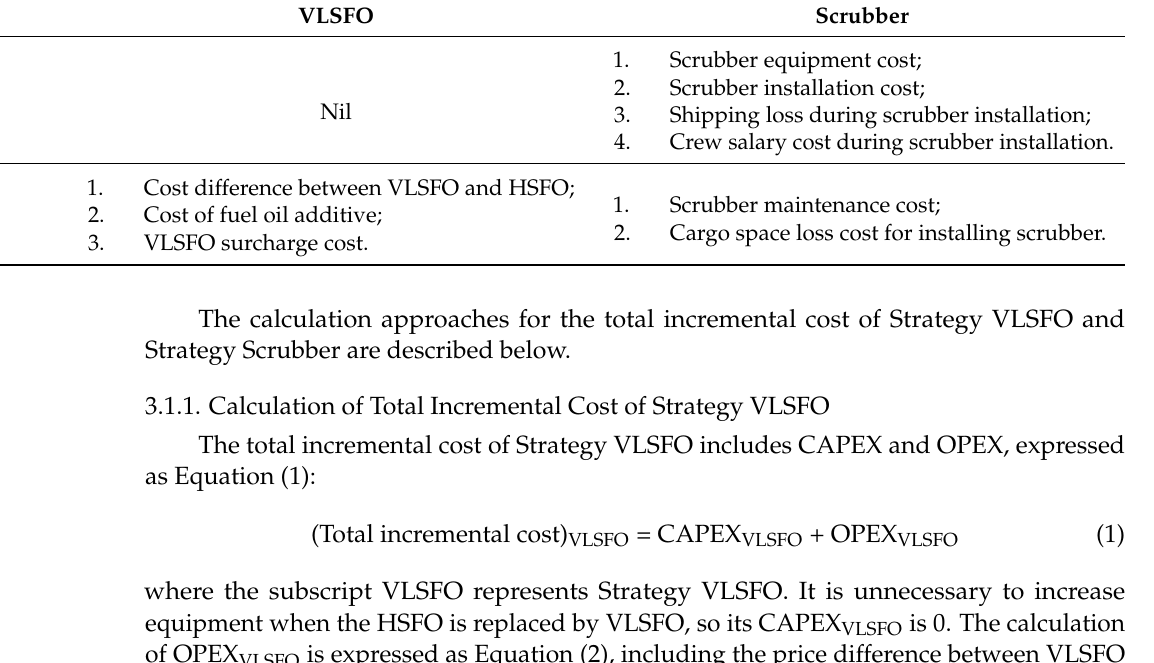
Table 3. Cost items of implementing Strategy very low-sulfur fuel oil (VLSFO) and Strategy Scrubber. Cost Item